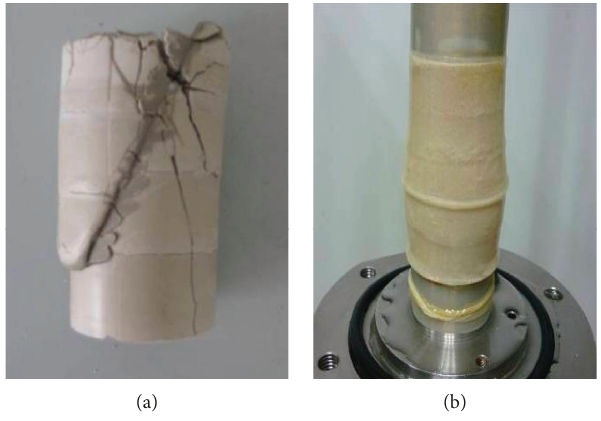
Figure 3: Typical failure forms of test samples of GMZ001. (a) Brittle failure. (b) Plastic failure.